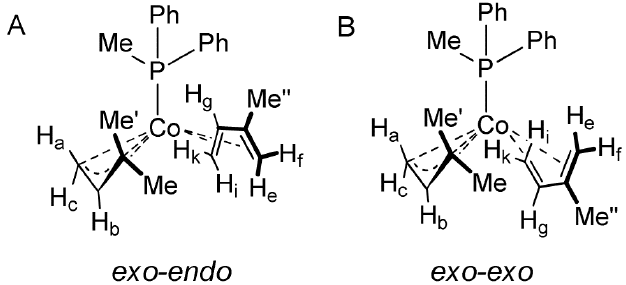
Figure 6. Possible reciprocal spatial orientations of the allyl group and the isoprene monomer for ( η 3 ‐ C 5 H 9 )( η 4 ‐ C 5 H 8 )Co(PMePh 2 ) ( 3 ): exo ‐ endo ( A ) and exo ‐ exo ( B ).